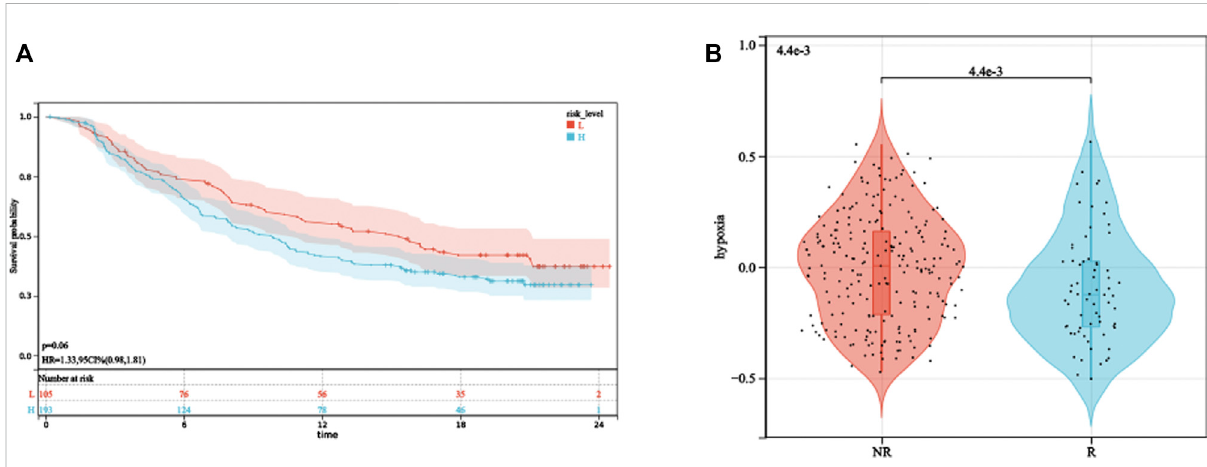
FIGURE 8 HPRSpredictsICBtherapeuticresponse. (A) Kaplan – MeieranalysisofHPRSintheIMvigor210dataset. (B) Differencesinhypoxialevelsbetween ICB therapy-response and non-response